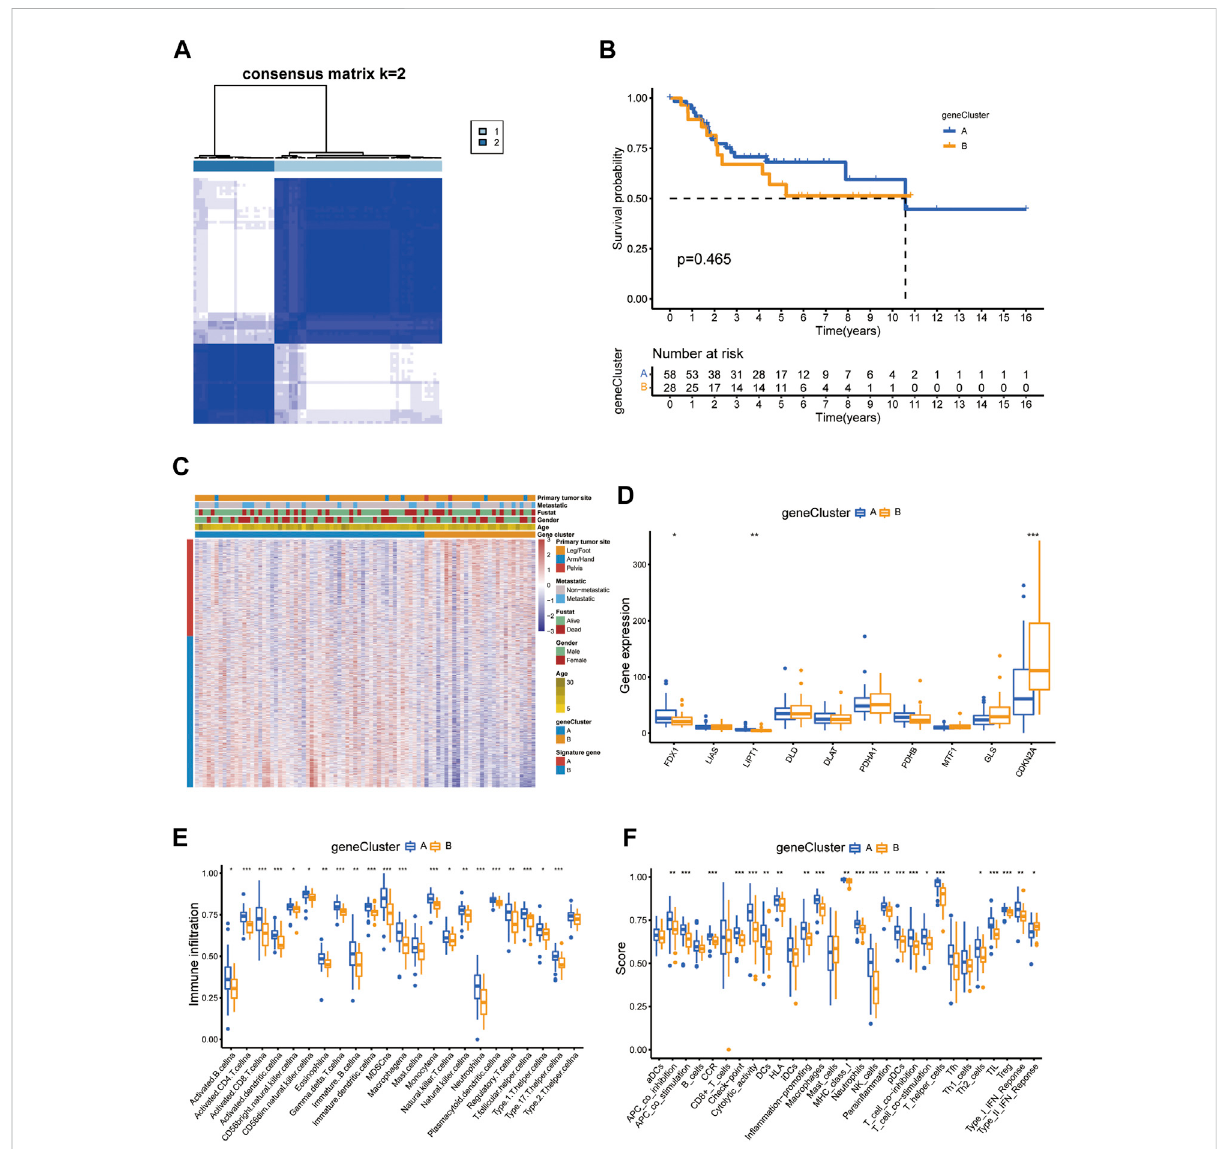
FIGURE 7 Prognosis and TME characteristics in two cuproptosis gene clusters for OS patients. (A) Consensus matrix heatmap de fi ning two gene clusters according to the prognostic DEGs. (B) Kaplan-Meier survival analysis for patients in the two gene clusters. (C) Clinical features of the two gene clusters. (D) TheboxplotshowsvariationsintheexpressionofCUGsbetweenthetwogeneclusters.Boxplotsshowed (E) abundanceof23in fi ltrating immune cell types and (F) differences in immune scores in the two gene clusters. ( p < 0.05 *; p < 0.01 **; p < 0.001